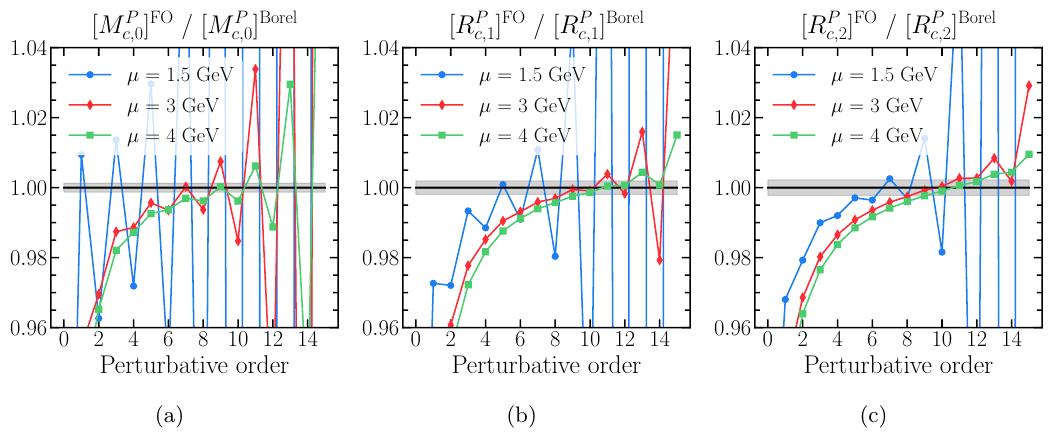
in the large- c,n . The gray band represents the c,n